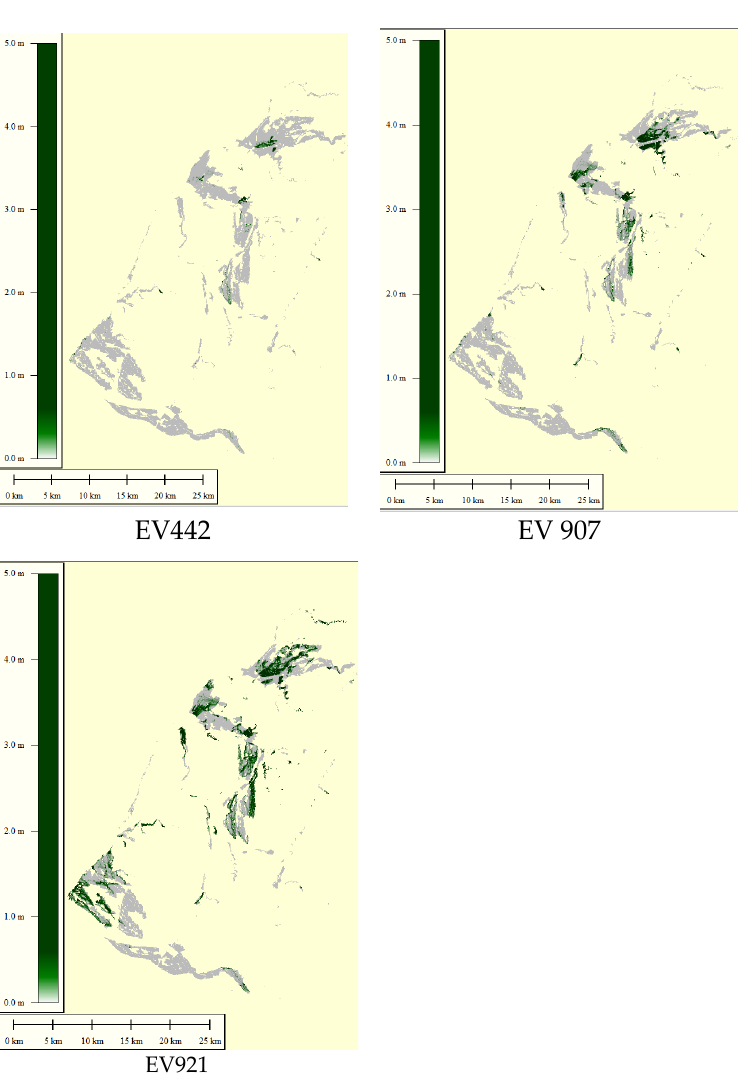
Figure 10. Graphical illustration of the flooding area within Miaoli County drawn based on the maximum of the resulting inundation depths.